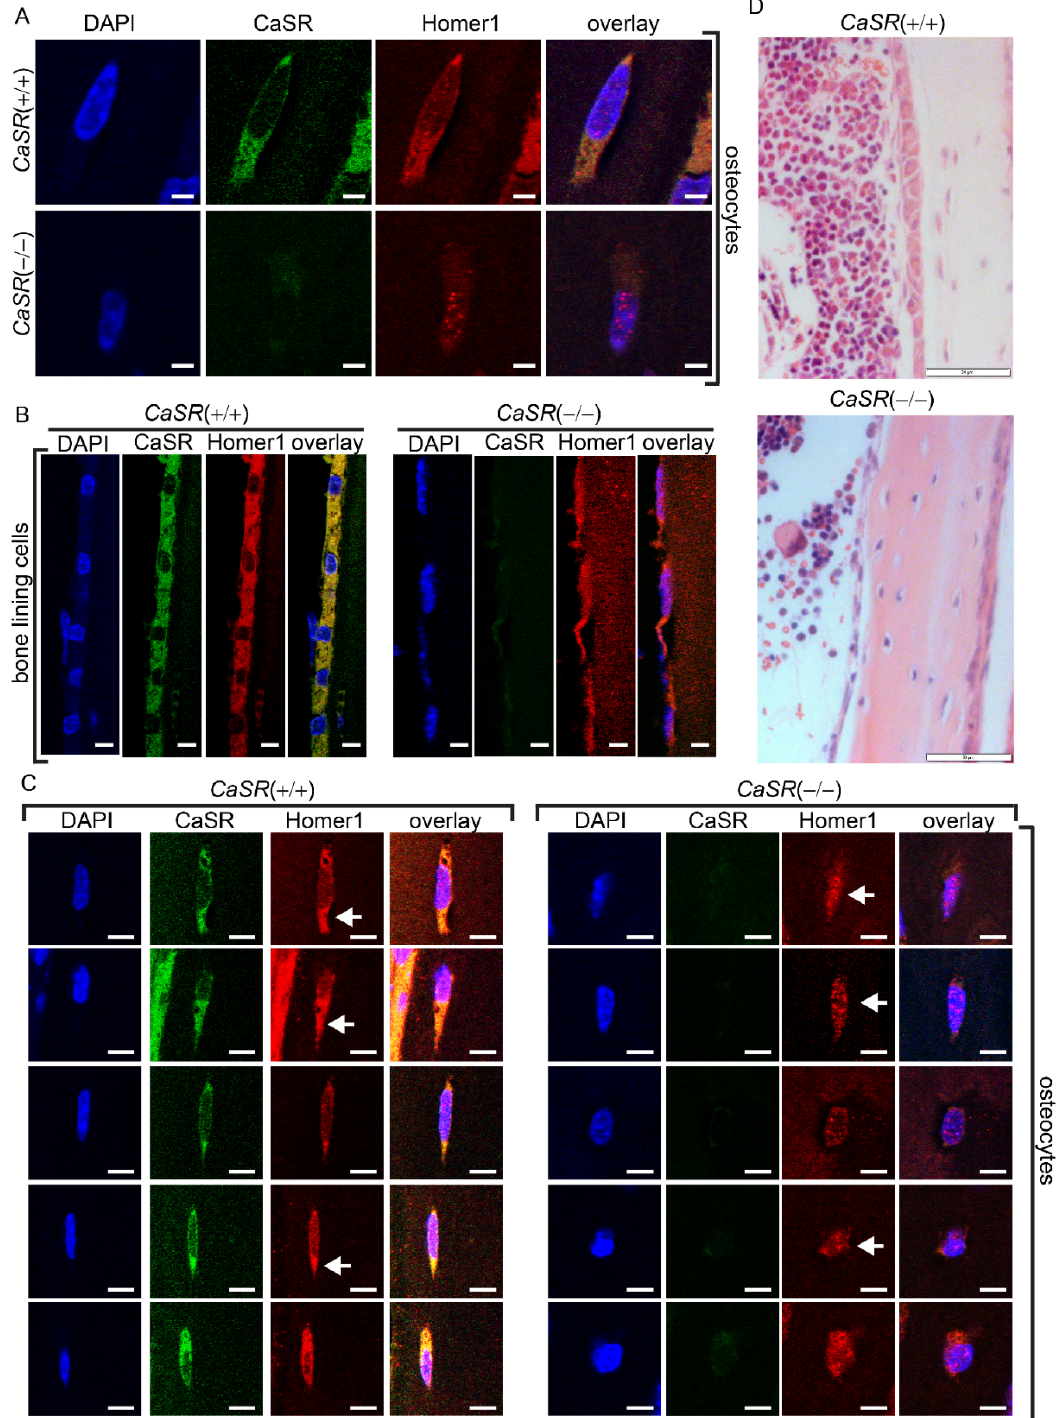
Figure 3. The protein levels of Homer1 and CaSR were linked in bone cells in vivo, and the sub-cellular distribution of Homer1 was modulated by CaSR. ( A , B ) Confocal microscopy of ( A ) an osteocyte embedded in the mineralized matrix or ( B ) bone lining cells of long bones of wt ( CaSR +/+), or CaSR knockout ( CaSR − / − ) mice, stained for Homer1 (red) or CaSR (green). Cell nuclei (blue) stained by DAPI, 100 × objective (scale bar = 5 µ m). ( C ) Confocal microscopy of several individual osteocytes from the long bones of CaSR +/+ and CaSR − / − mice stained for Homer1 (red) or CaSR (green). Cell nuclei (blue) stained by DAPI, 100 × objective (scale = 5 µ m). White arrows indicate examples of changes in Homer1 cellular localization compared to wt between CaSR phenotypes. ( D ) H&E stain of long bones of wt ( CaSR (+/+)) or CaSR knockout ( CaSR ( − / − )) mice. Scale bar = 50 µ